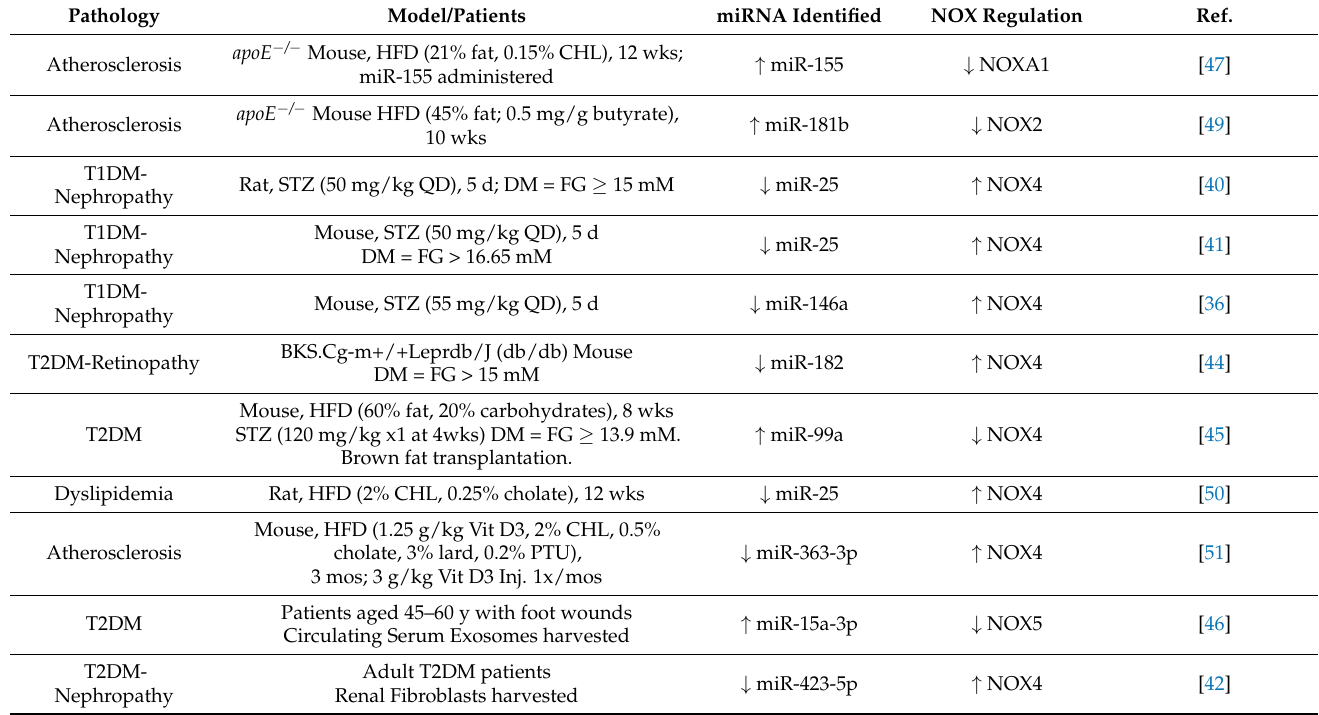
Table 1. Differential Expression of miRNAs and NOX Isoforms in Models or Patients with Obesity or Comorbid Diseases Legend: HFD—High Fat Diet; CHL—Cholesterol; T1DM—Type I Diabetes Mellitus; STZ—Streptozotocin; QD—Daily; DM—Diabetes Mellitus; FG—Fasting Blood Glucose;